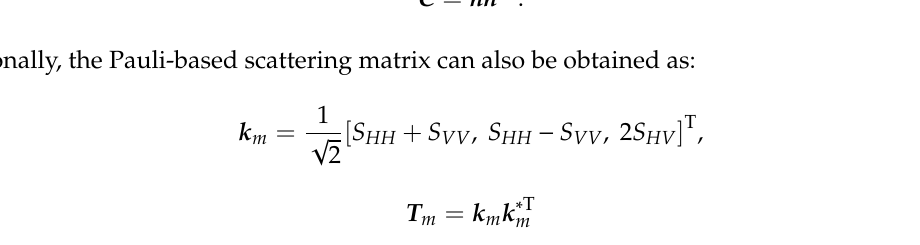
Figure 3. An S-SAE network structure.